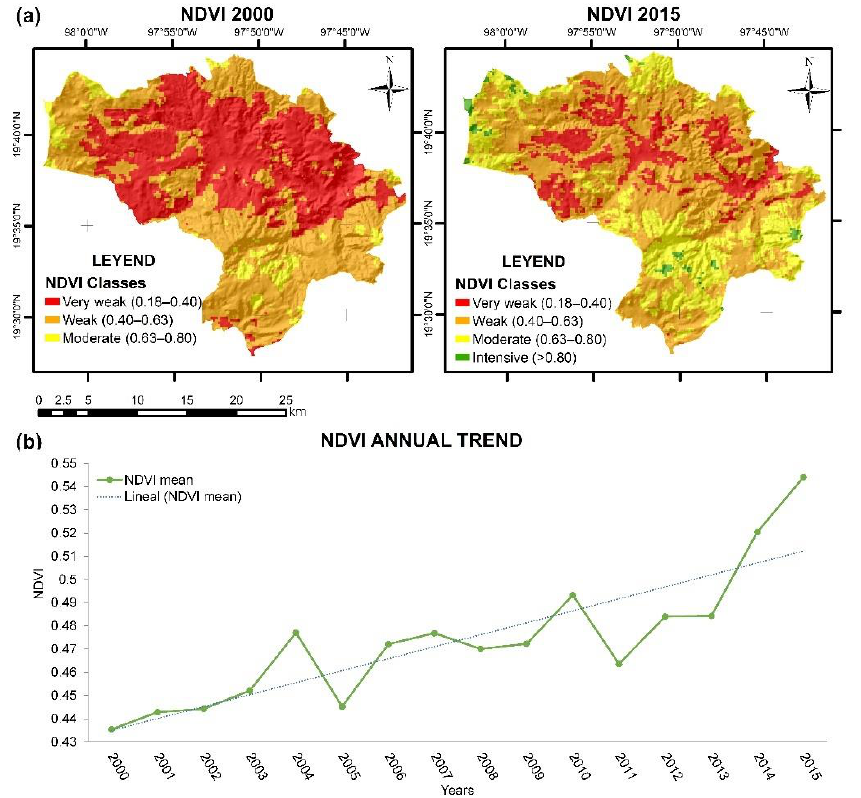
Figure 3. ( a ) Spatial distribution of NDVI classes for 2000 and 2015 in Ixtacamaxtitlan, Puebla, México; ( b ) Mean annual trend of NDVI for 2000 to 2015.